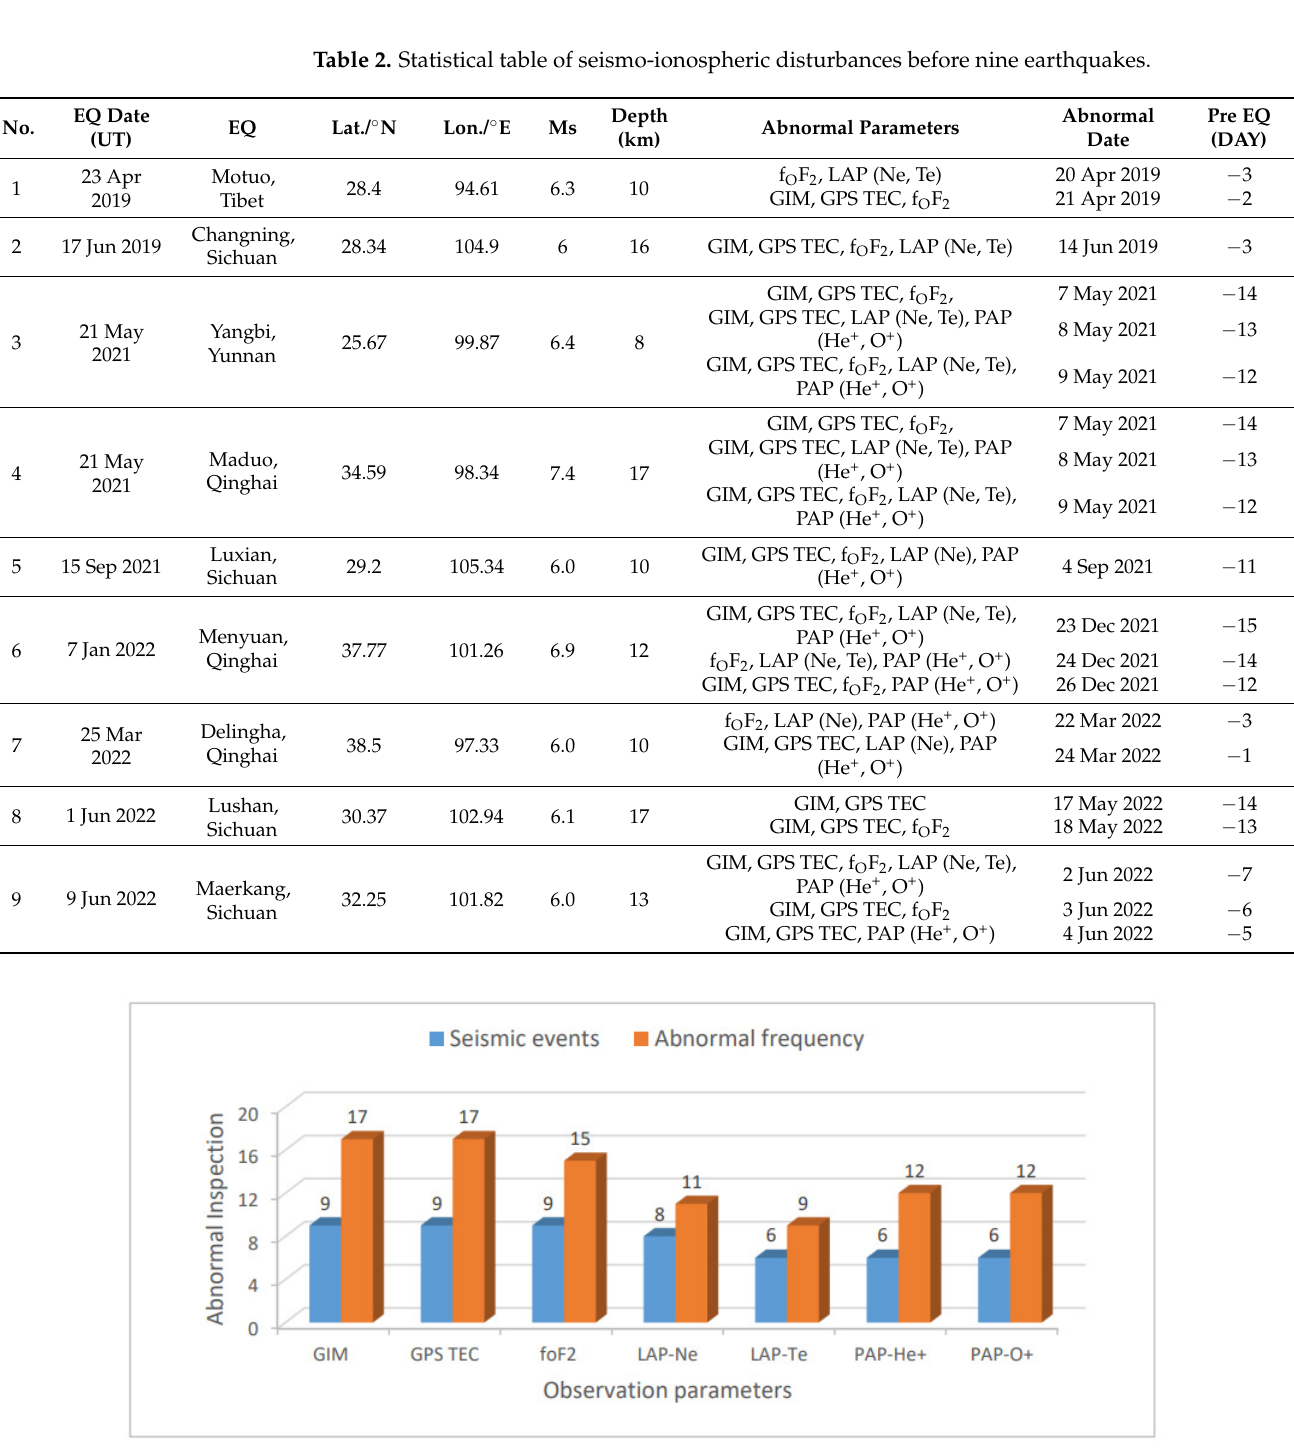
Figure 9. Abnormal test results for observation parameters. The blue bar represents seismic events, and the red bar represents abnormal frequency.